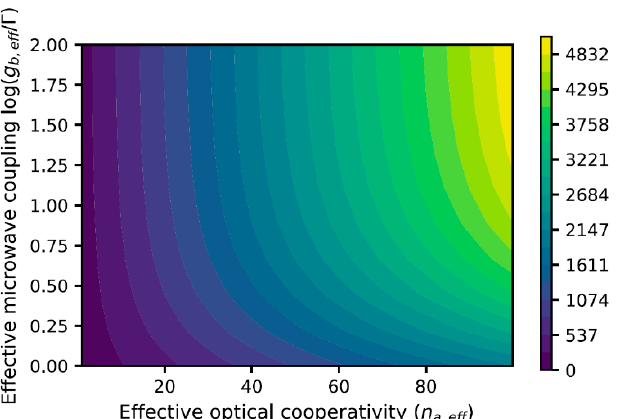
Figure 5. Saturation gain as a function of optical cavity cooperativity and microwave cavity coupling strength in a detector comprising an ensemble of NV centers.